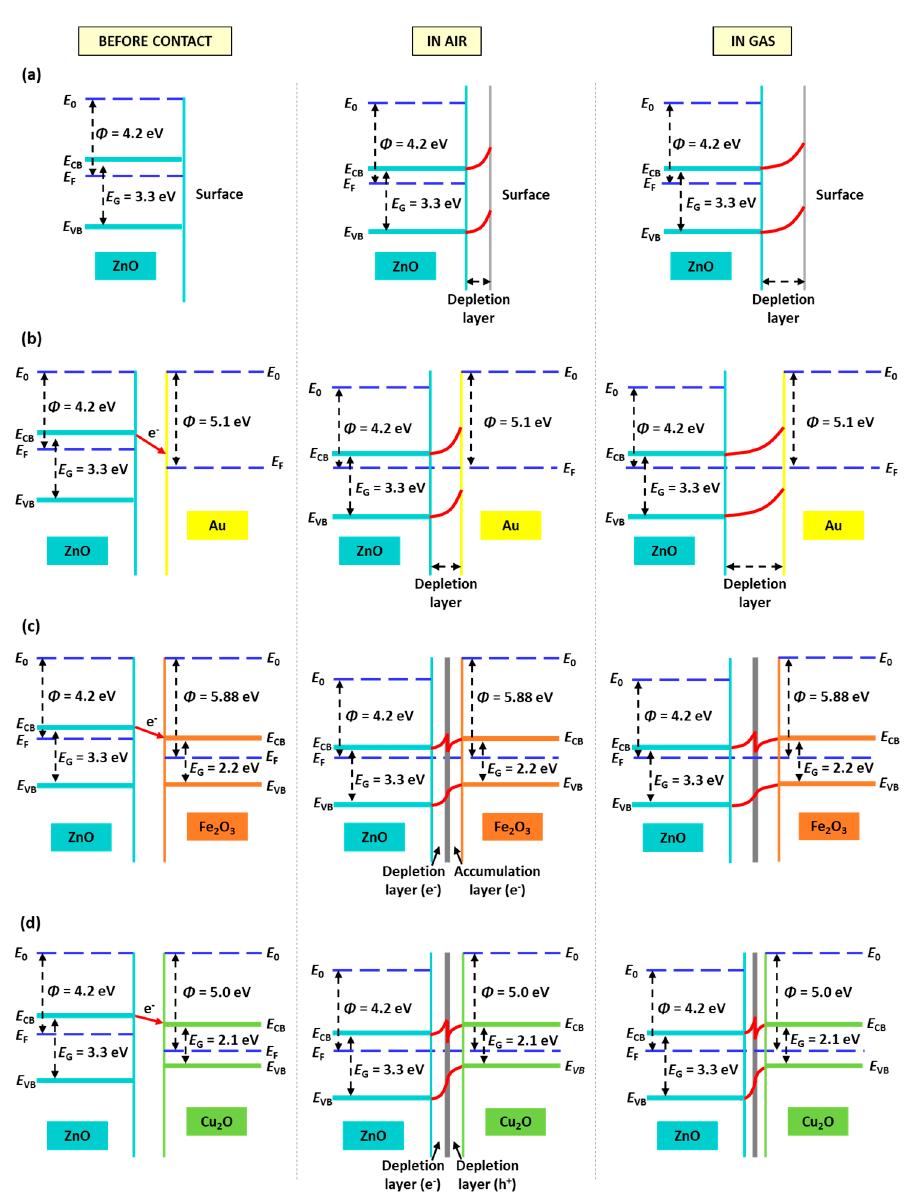
Figure 15. Energy band diagrams of ( a ) ZnO, ( b ) Au@ZnO, ( c ) Fe 2 O 3 @ZnO, and ( d ) Cu 2 O@ZnO films at room temperature and before contact between ZnO with Au, Fe 2 O 3 , or Cu 2 O (first column), after contact and in air (second column), and in gas (third column).